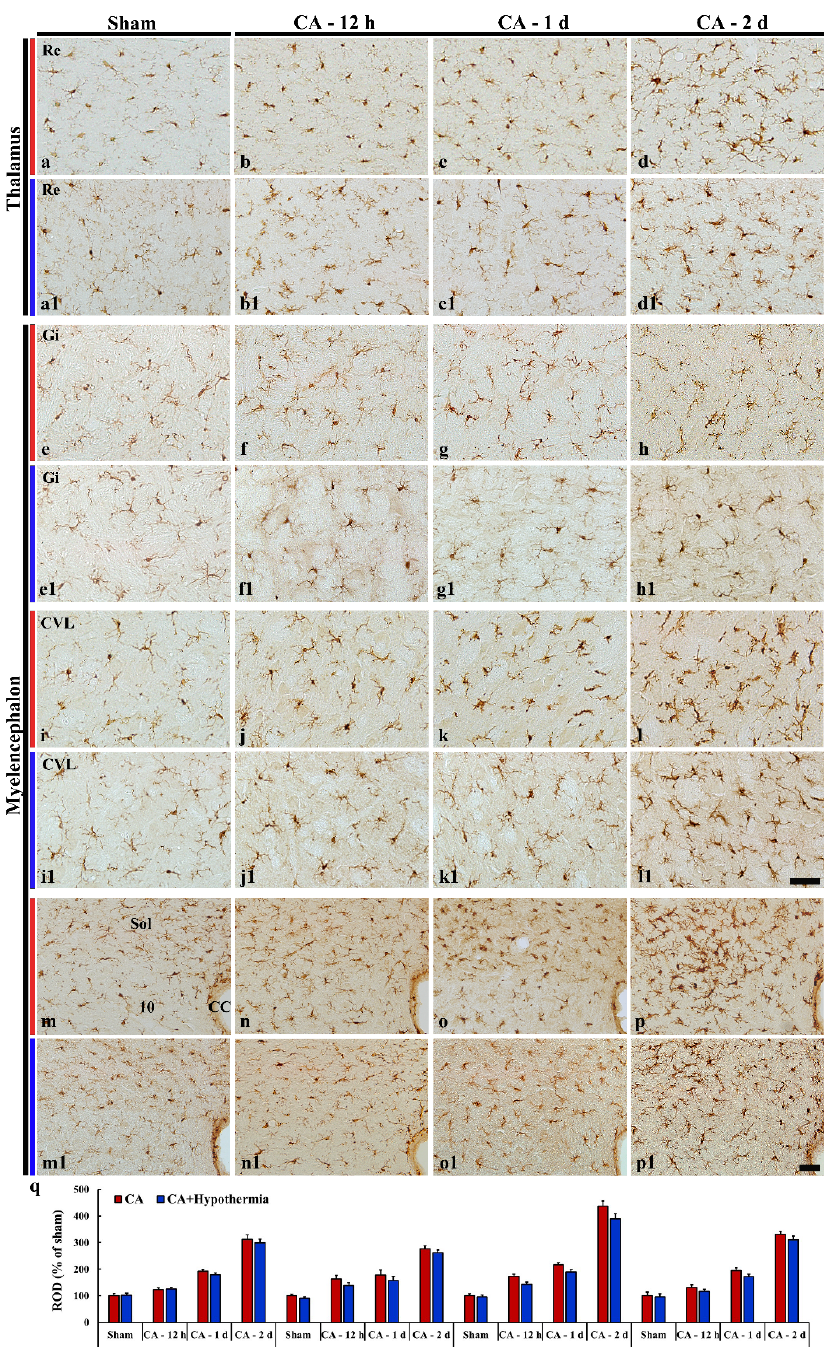
Figure 5. Iba-1 immunohistochemical staining in the thalamus ( a – d ) and myelencephalon ( e – p ) of the sham operated ( a , a1 , e , e1 , i , i1 , m , m1 ), CA operated ( b – d , f – h , j – l , n – p ), and CA/hypothermia operated ( b1 – d1 , f1 – h1 , j1 – l1 , n1 – p1 ) groups. Typical resting form of Iba-1 immunoreactive microglia are found in the sham operated group. After CA, Iba-1 immunoreactive microglia are morphologically activated, and Iba-1 immunoreactivity is increased with time after CA. Iba-1 immunoreactivity in the CA/hypothermia operated group is not significantly different comparted to that in the CA operated group. 10, dorsal motor nucleus of vagus; CVL, caudoventrolateral reticular nucleus; Gi, gigantocellular reticular nucleus; Re, reuniens thalamic nucleus; Sol, nucleus of solitary tract. Scale bars = 50 μ m. ( q ) Quantitative analysis of Iba-1 immunoreactivity in the CA and CA/hypothermia groups ( n = 9 per group). The bars indicate the means ± SEM.